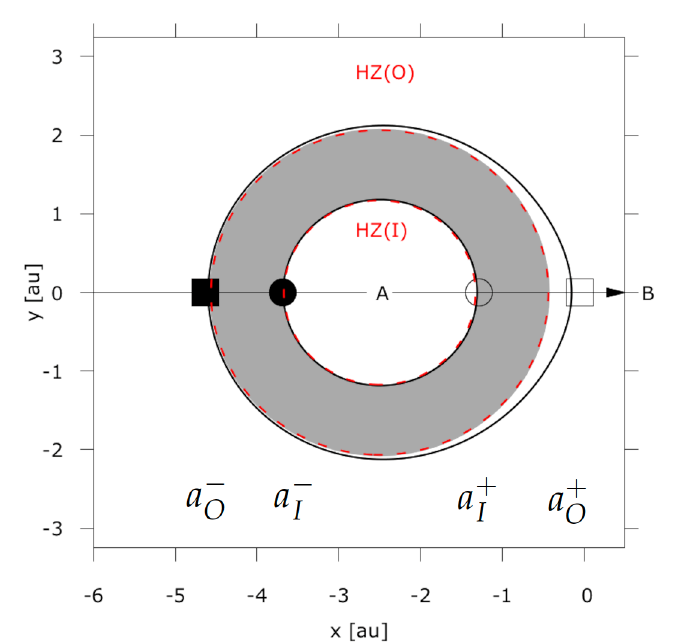
(+ , − ) Figure 3. A zoom on the brighter star in Figure 1. The distances a calculated from Equations (15) I , O and (16) are intersections of the isophotes corresponding to habitable zone limit insolation values with the line connecting the center of both stars (y = 0). The inner (HZ (I)) and outer (HZ (O)) borders of the single star habitable zone are given by red dashed lines. The intersections of the isophotes with (+ , − ) the abscissa for the inner HZ border a are shown with empty and full circles, whereas the outer I (+ , − ) borders a are denoted by empty and full squares, respectively. The radiative habitable zone as O defined by [5] is the area shown in gray. The radiative habitable zone constitutes a hollow sphere with inner radius a + and outer radius a − I O